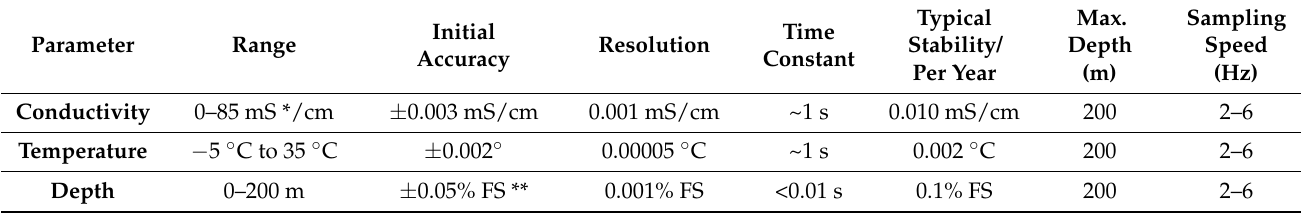
Figure 2. Map of 2019 hydrological stations. Table 1. The main characteristics of RBR-Concerto CTD instrument.